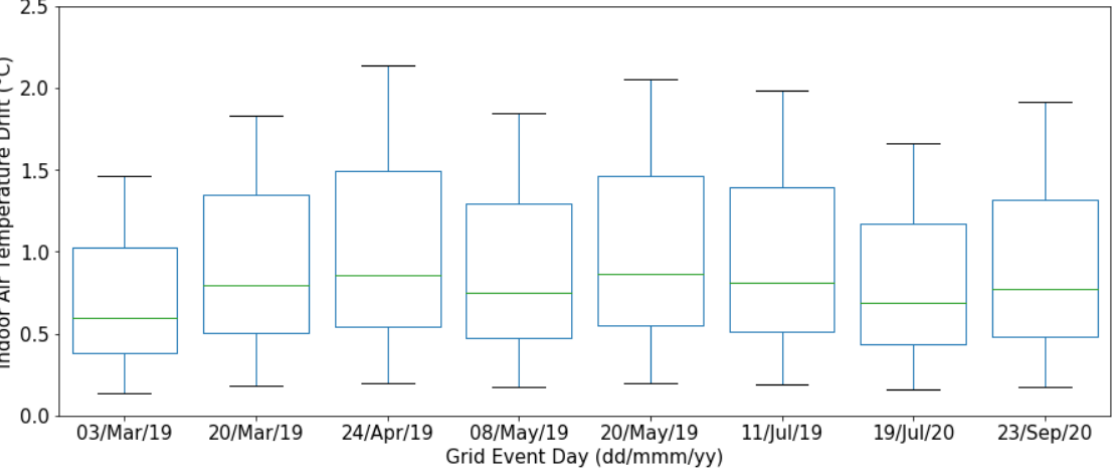
Figure 6. Overview of risk levels for each grid frequency event day and shutoff duration, with no risk represented in green and any excursion outside of allowable limits or comfort criteria causing a risk coloured in red.